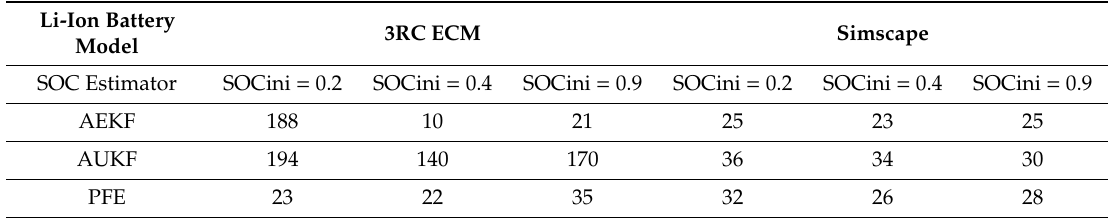
Table 2. The response speed convergence of AEKF SOC, UAKF SOC and PFE SOC (in seconds). Qnom